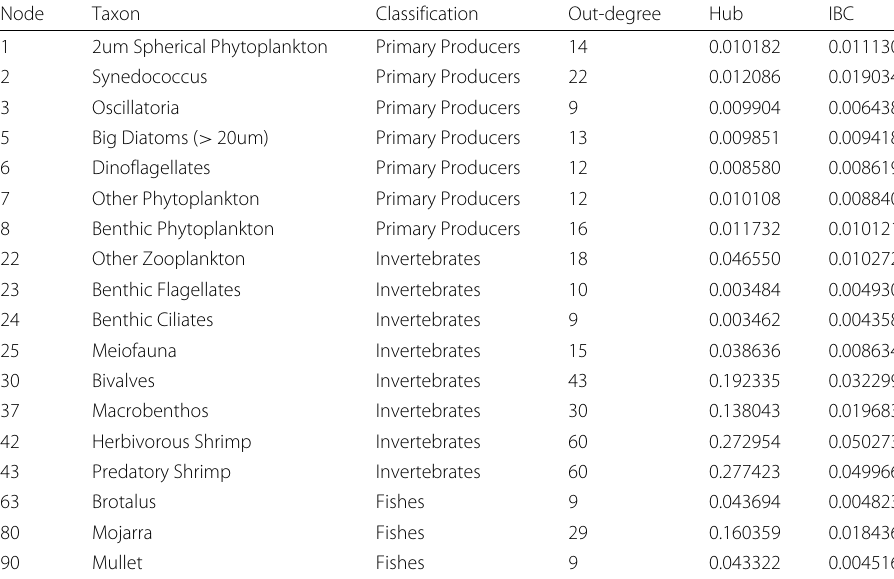
Table 2 Nodes with significantly high IBC in the Florida Bay food web. The values of out-degree and Hub score are also shown Node Taxon Classification Out-degree Hub IBC